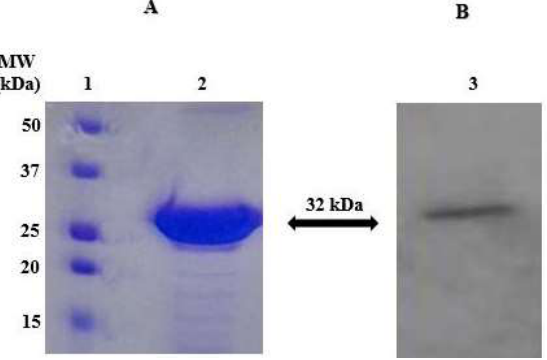
Figure 1. Sodium dodecyl sulfate (SDS)-polyacrylamide gel electrophoresis (PAGE) (Panel A ) and Western blot (Panel B ) of SpiCA3. Recombinant SpiCA3 was subjected to SDS-PAGE (Lane 2 , Panel A ) and then electroblotted and incubated with anti-His Tag (Lane 3 , Panel A ). Lane 1 , molecular markers (Panel A ).